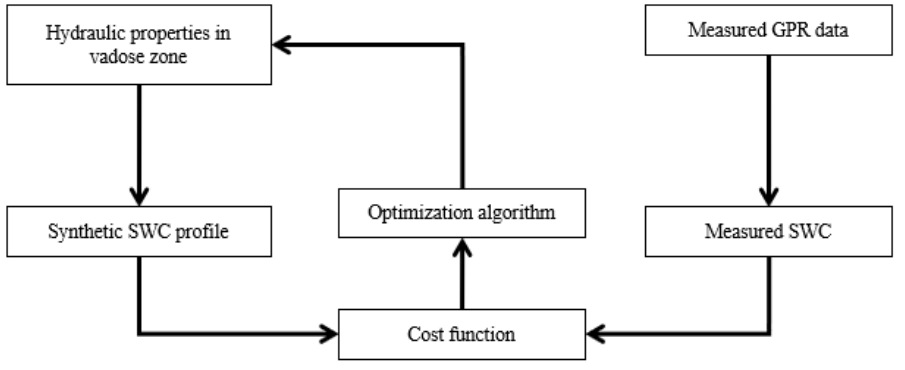
Figure 2. Flowchart of sequential inversion.